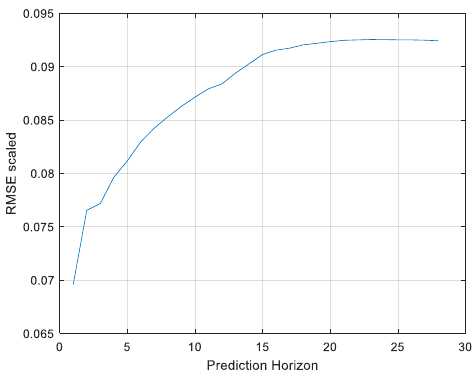
Figure 14. Evolution of RMSE over the prediction horizon — M 2 .